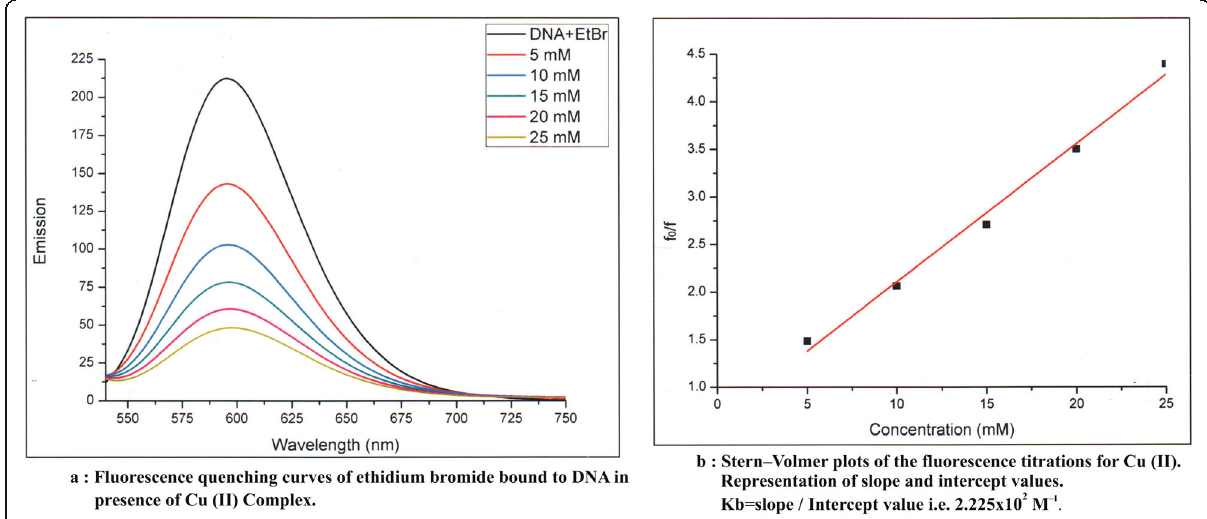
Fig. 8 a Fluorescence quenching curves of ethidium bromide bound to DNA in presence of Cu (II) Complex. b Stern-Volmer plots of the fluorescence titrations for Cu (II) Complex. Representation of slope and intercept values. Kb = slope/Intercept value i.e. 2.225 × 10 2 M